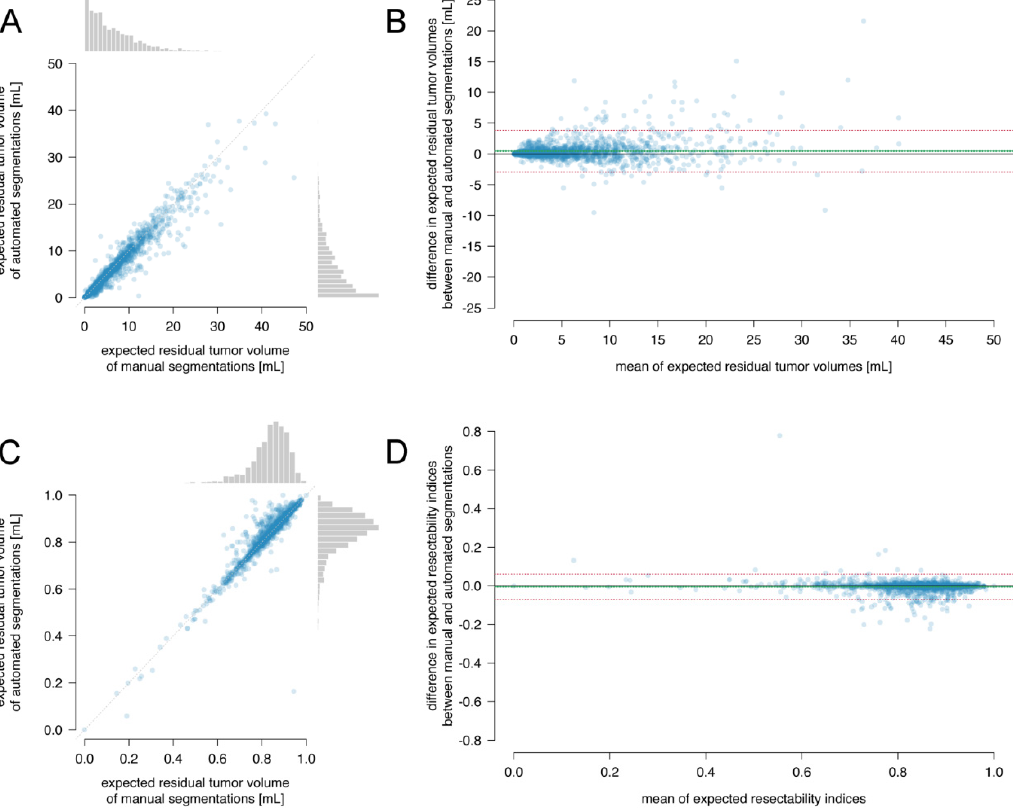
Figure 6. Comparison between automated and manual segmentations for ( A , B ) expected residual tumor volumes and ( C , D ) expected resectability index. In the scatterplots ( A , C ), each dot represents the data of one patient. The diagonal indicates the identity line. The boxplots display the distributions with median, 25% and 75% quartiles as hinges and 1.5 times the interquartile distance as whiskers. The Bland–Altman plots ( B , D ) of the mean of expectations versus the difference between expectations. Each dot represents one patient. The bias is plotted as solid line with 95% CI as dotted lines. The limits of agreement are plotted as dashed